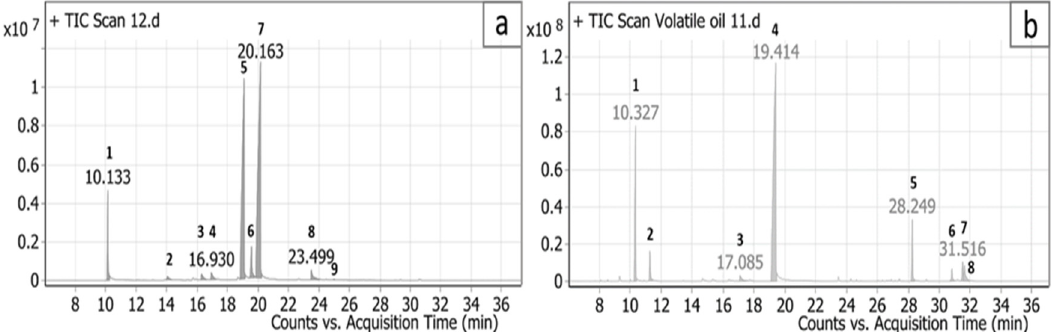
Figure 1. Total ion current (TIC) chromatogram of the volatile oil of Cymbopogon citratus ( a ) and Cymbopogon proximus ( b ) (The peak numbers are described in Tables 1 and 2). Table 1. The main constituents of Cymbopogon citratus EO.